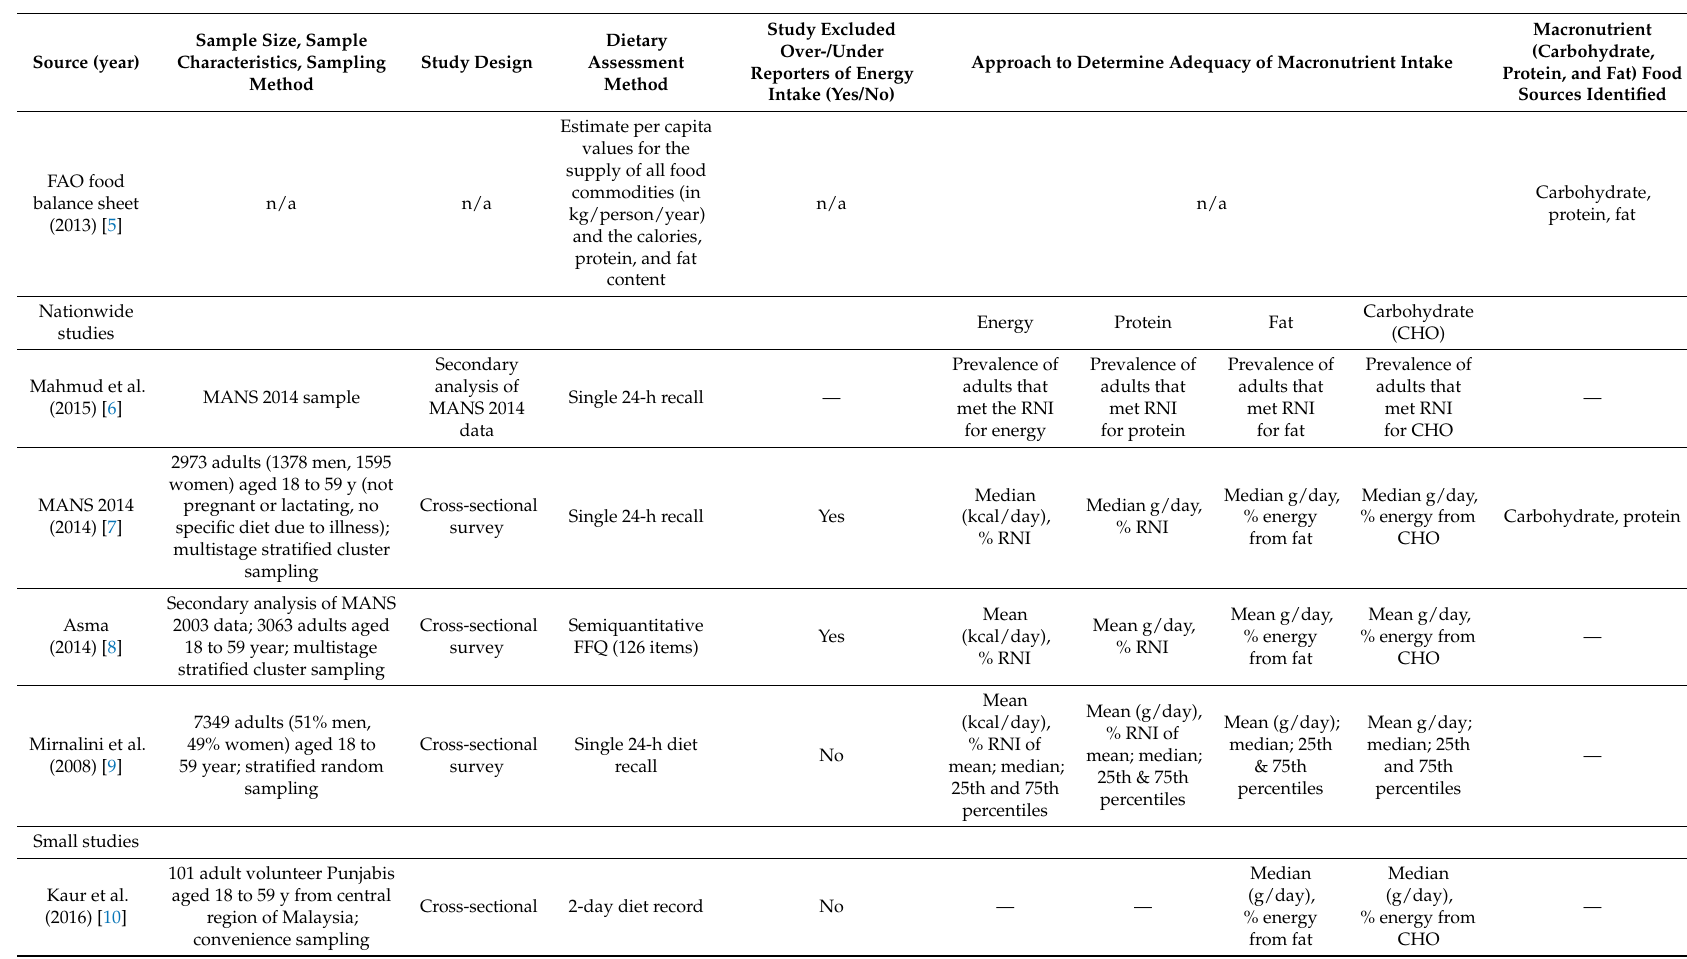
Table 1. Characteristics of included